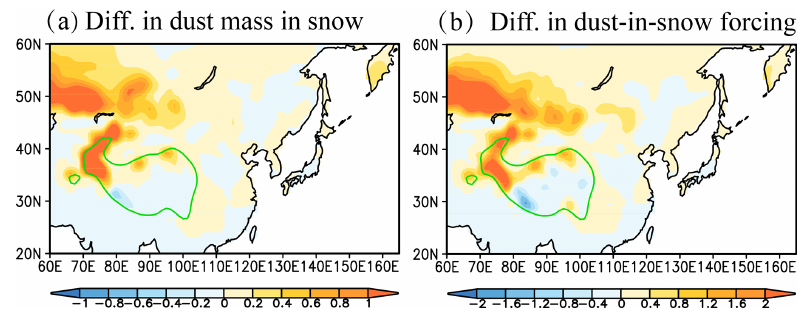
Figure 12. Spatial distribution of the MAM composite difference between the strongest and weakest TPSH years (strongest–weakest) for the model in (a) dust mass in snow column (gm − 2 ) and (b) dust-in-snow forcing (Wm − 2 ). The green-contour area indicates the plateau above